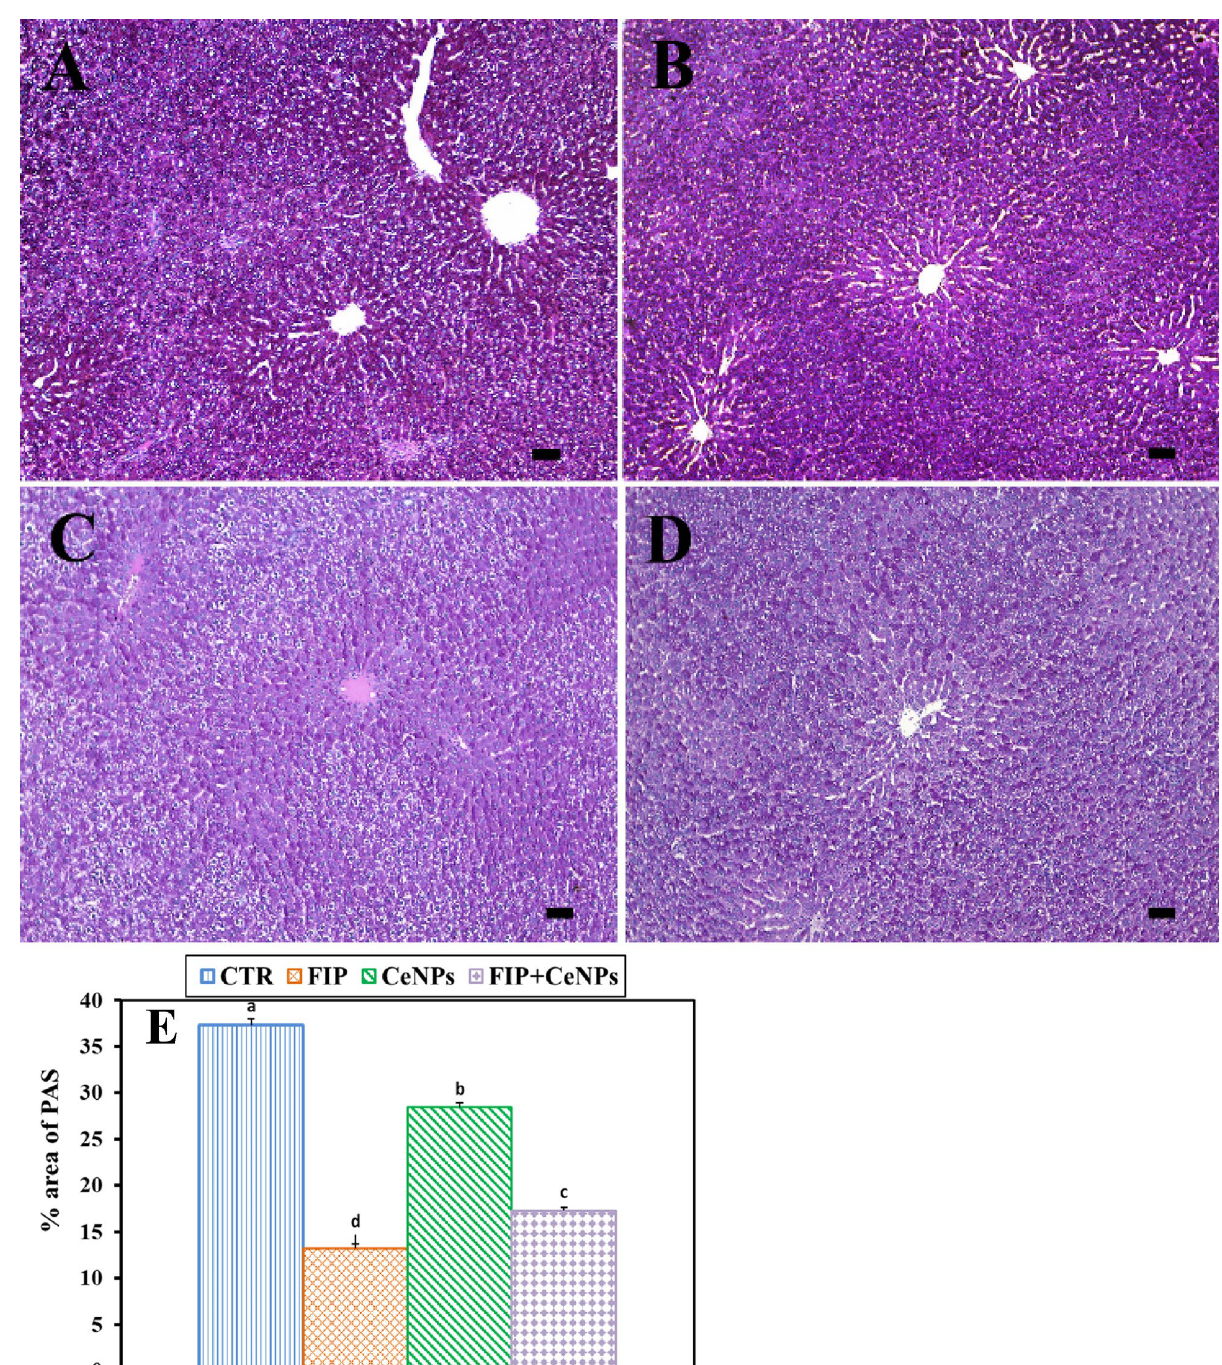
Figure 2. Histochemical staining of rat liver by periodic acid Schiff (PAS). ( A ) Negative control group. ( B ) CeNPs group. ( C ) FIP group. ( D ) FIP group that treated with the CeNPs group. Scale bar = 50 µm. ( E ) Quantification of PAS in the hepatic tissues in different groups Data expressed as Mean ± SE, analyzed using one-way ANOVA at P ≤ 0.05, column with different letters (a, b, c, & d) indicate significant difference among the values of different